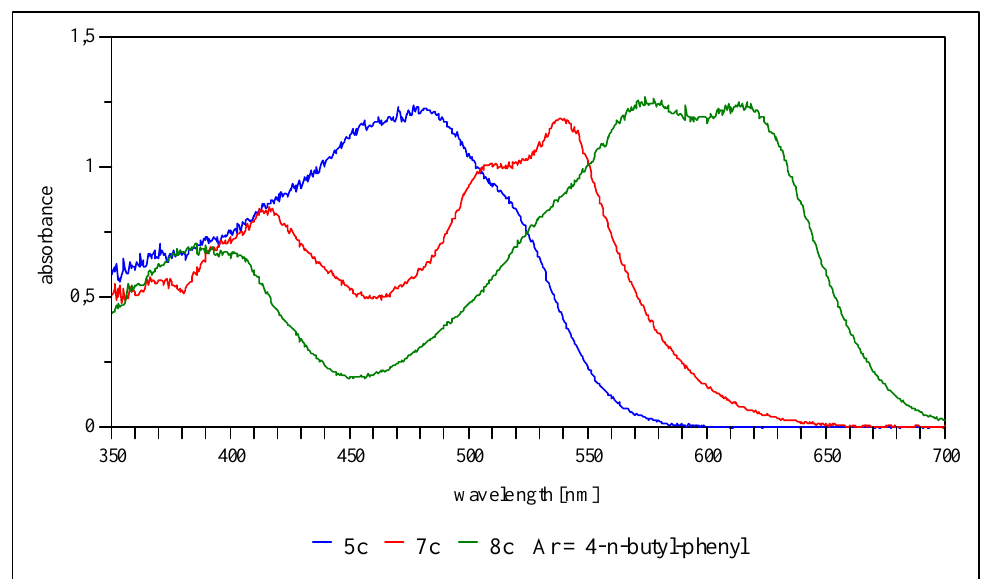
Figure 1. UV/vis spectra (THF) of anthracene derivative 5c , deprotonated 7c and protonated 5c